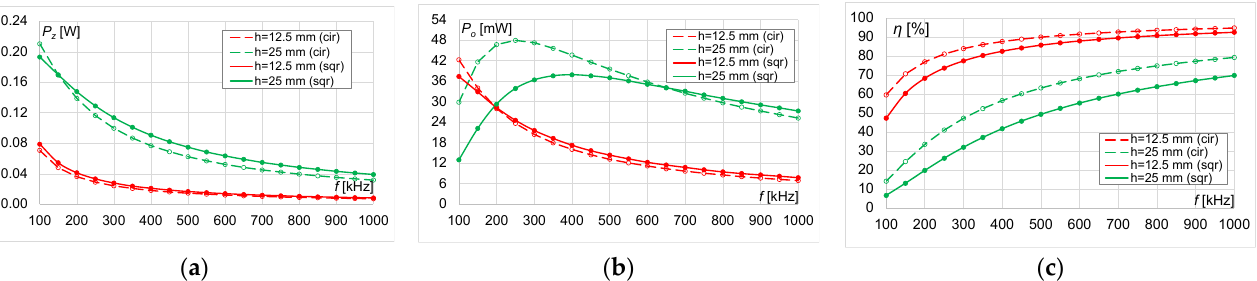
Figure 13. Results for circular and square coils with r = 25 mm and number of turns n = 50 at different distances ( h = 12.5 mm and h = 25 mm): ( a ) transmitter power, ( b ) receiver power and ( c ) power transfer efficiency.